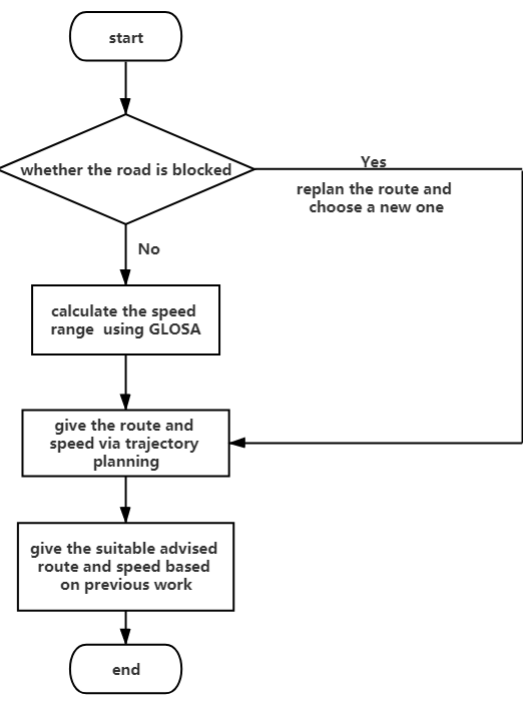
Figure 1. The process when closing to the